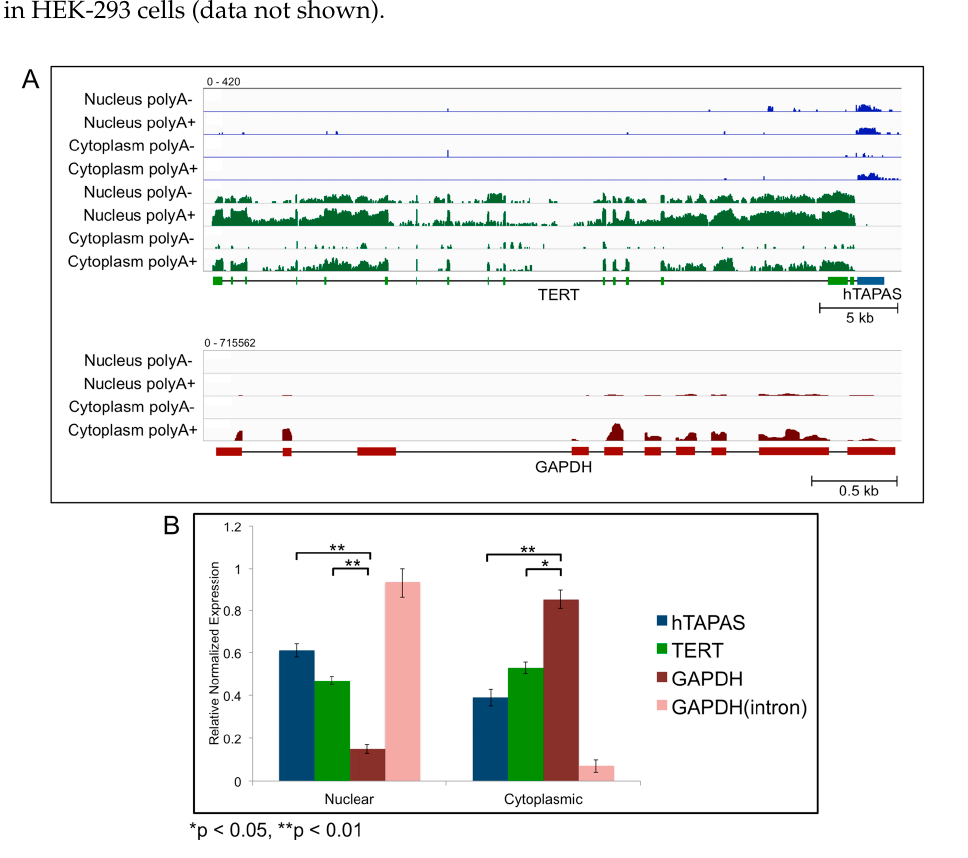
Figure 2. Sub ‐ cellular localization of hTERT and hTAPAS RNAs ( A ) Normalized and stranded RNA ‐ seq (Bedgraph) transcription coverage for hTERT (green) and hTAPAS (blue) expression are depicted for the polyadenylated (polyA+) and non ‐ polyadenylated (polyA ‐ ) transcripts in the nuclear and cytoplasmic fractions, from the human B ‐ cell cell line (GM12878). All plus strand (blue) and minus strand (green) track signals are depicted on a log ‐ scale (0–420). Transcription coverage for corresponding transcripts of glyceraldehyde ‐ 3 ‐ phosphate dehydrogenase ( GAPDH ) (red) are depicted as a control, on a log scale (0–715562). Represented data are from the ENCODE Consortium. ( B ) Abundance of hTAPAS , hTERT and GAPDH (mRNA and pre ‐ mRNA) transcripts in the nucleus and cytoplasm cellular fractions determined by quantitative Reverse Transcription PCR (qRT ‐ PCR) after sub ‐ cellular fractionation of HEK ‐ 293 cells.